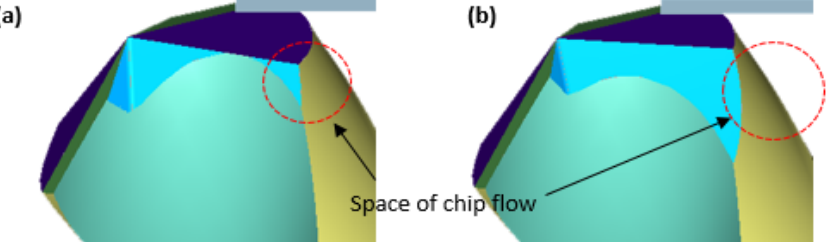
Figure 14. Space for chip flow showing two geometries with same primary clearance angle and point angle where ( a ) drill with 30° of chisel edge angle ( b ) drill with 45° of chisel edge angle.